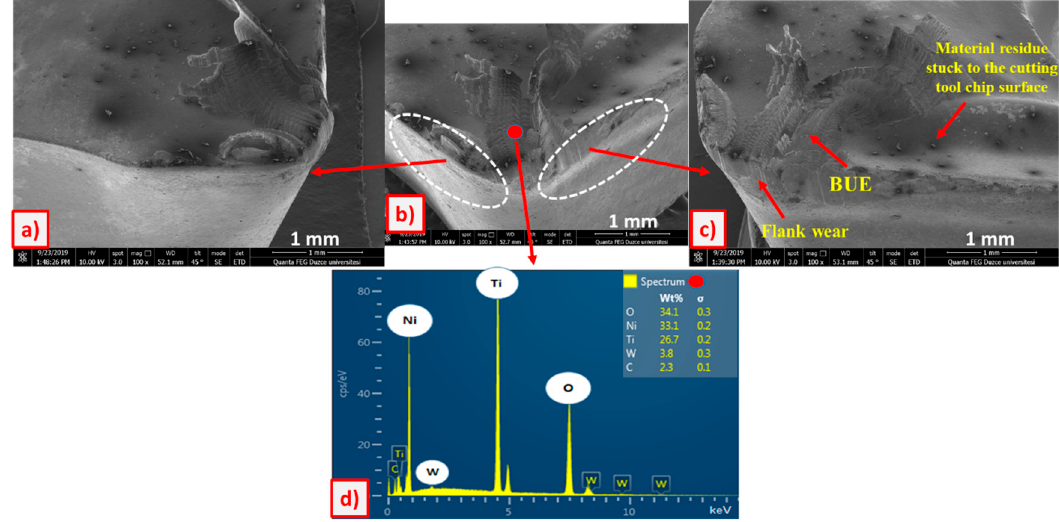
Figure 12. The SEM image ( a – c ) and EDX analysis values ( d ) of tool wear resulting from the milling of NiTi SMA with the cutting tool with 0.8 mm r ε under different machining parameters.